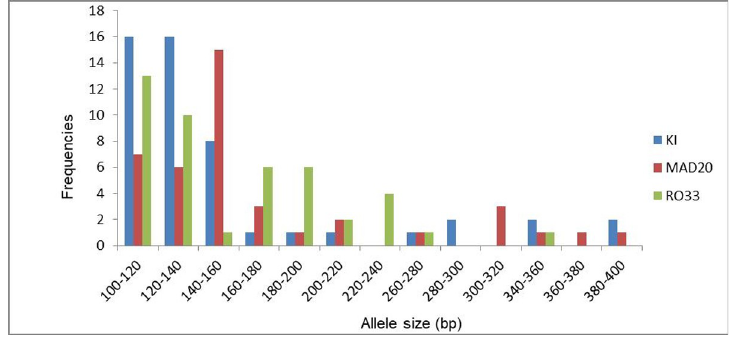
Fig 2. Prevalence of K1, MAD20 and RO33 allelic families of msp-1 isolates based on alleles sizes (base pairs).